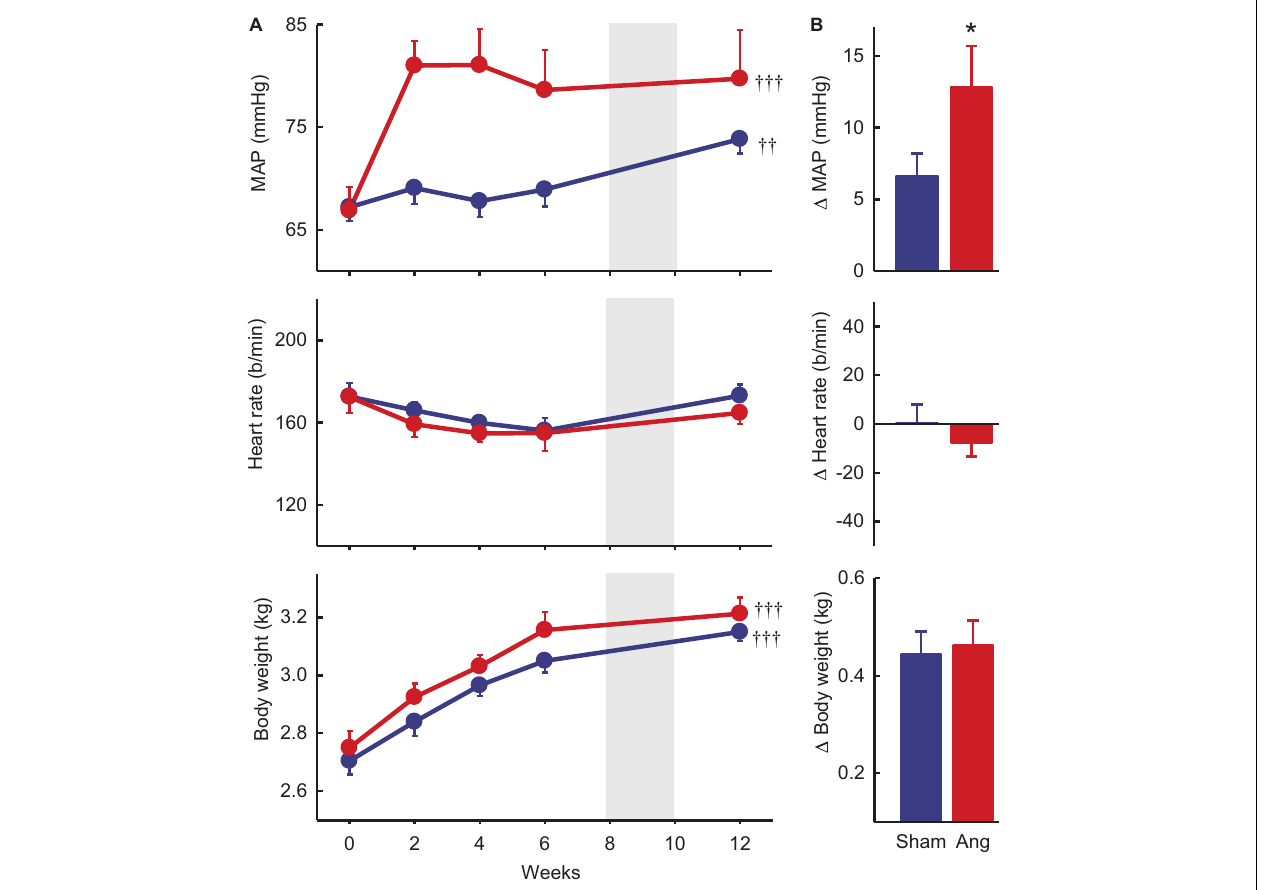
FIGURE 3 | Mean arterial pressure (MAP), heart rate and body weight at baseline and after Ang II or sham treatment. (A) Average values at baseline (week 0) and to 12 weeks after beginning Ang II (red, n = 8) and sham (blue, n = 10) treatment. Data are mean ± SEM. Gray panel shows the period when surgery occurred. †† P < 0.05 and ††† P < 0.001 for week 12 vs week 0. (B) Average changes from baseline at week 12. Data are mean difference ± SE of the difference. * P < 0.05 for Ang II vs sham.